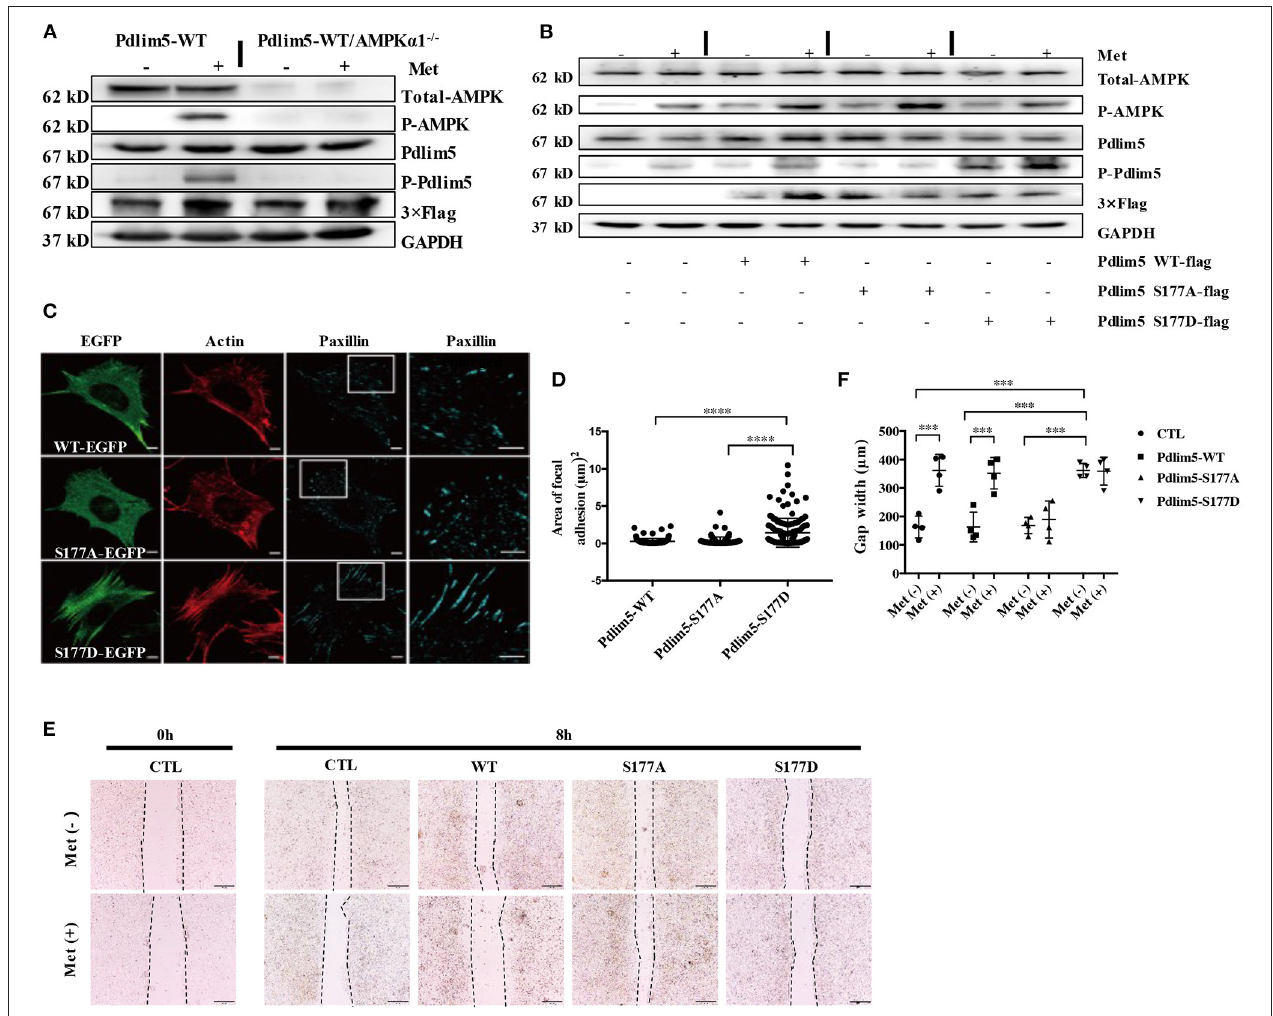
FIGURE 2 | Metformin inhibits lamellipodia formation and enforces focal adhesions in vascular smooth muscle cells (VSMCs) through the AMPK–Pdlim5 pathway. (A) Flag-WT-Pdlim5 VSMCs and AMPK α 1-null/EGFP-WT-Pdlim5 VSMCs were stimulated with metformin before detecting the phosphorylation level of AMPK and Pdlim5 with immunoblotting. (B) Metformin activates the AMPK–Pdlim5 signaling pathway. VSMCs were transfected with CTL siRNA or Pdlim5 siRNA. Pdlim5 siRNA-resistant flag-Pdlim5 (WT, S177A, or S177D) was added back by adenoviral-mediated gene delivery. The phosphorylation levels of AMPK and Pdlim5 were detected with western blotting. (C) GFP signal and immunostaining of actin and paxillin in KDR/EGFP-Pdlim5 cells (WT, S177A, and S177D). Actin and paxillin were stained with phalloidin and anti-paxillin antibody to display actin microfilaments and focal adhesions, respectively. The right panels are the magnified images of the region outlined by white boxes. Scale bar, 10mm. (D) The focal adhesion area of EGFP-Pdlim5 cells (WT, S177A, and S177D) were measured according to the paxillin-positive region in (B) and compared using one-way analysis of variance, followed by a post-hoc comparison with Dunnett’s method for multiple comparisons. **** P < 0.0001, n = 100. (E) Scratch assay of metformin-stimulated EGFP-Pdlim5 cells. Phase-contrast images of EGFP-Pdlim5 cells (WT, S177A, and S177D) 8h after scratching with or without metformin. Scale bar, 0.5mm. (F) Bar graph showing the gap width 8h after scratching [from (E) ]. Data are representative of means ± SEM from four independent experiments. The significance of the results was assessed using one-way analysis of variance, followed by a post-hoc comparison with Dunnett’s method for multiple comparisons. *** P < 0.001, n =